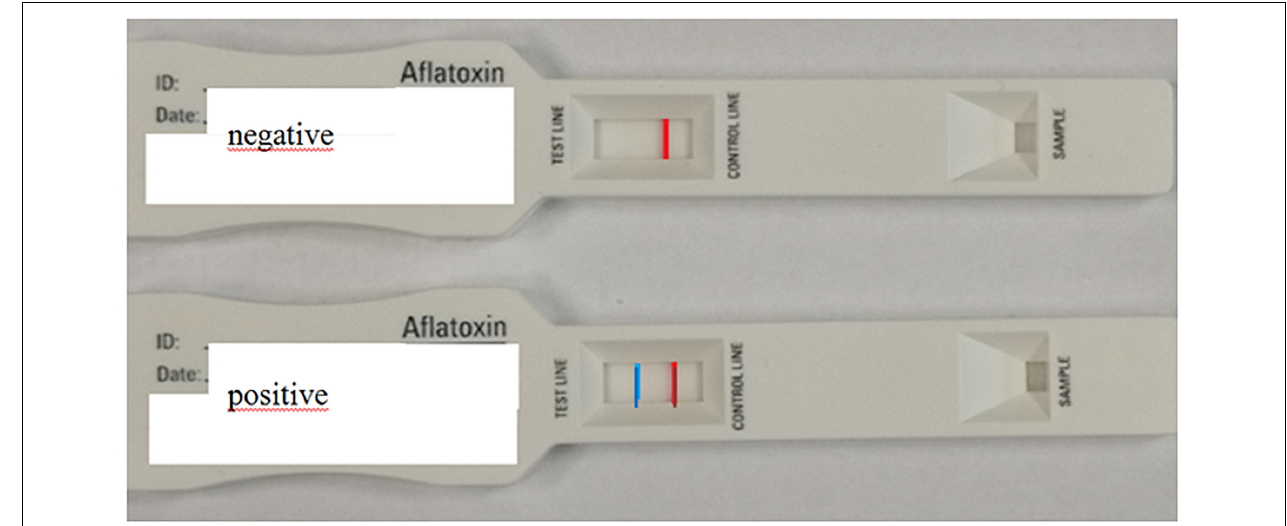
FIGURE 5 | Practical application of the lateral flow